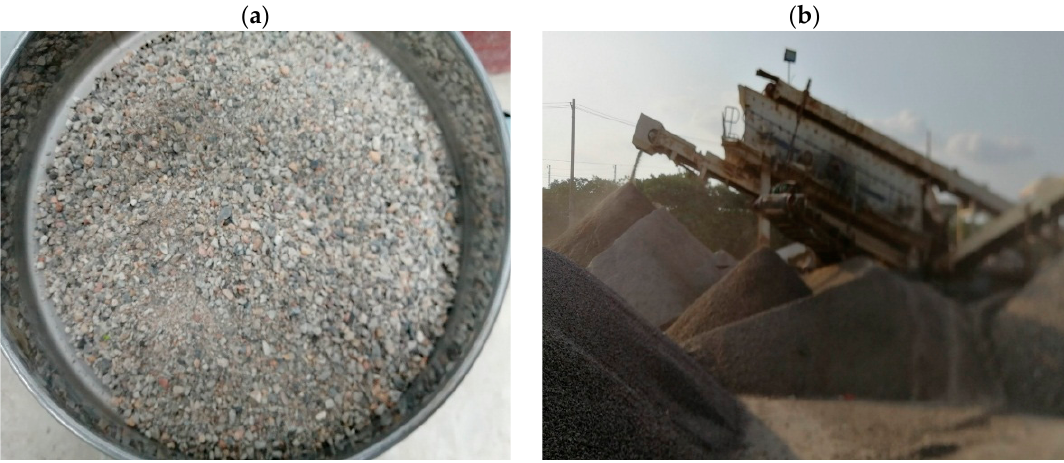
Figure 1. ( a ) Raw recycled concrete aggregate; ( b ) aggregate production.